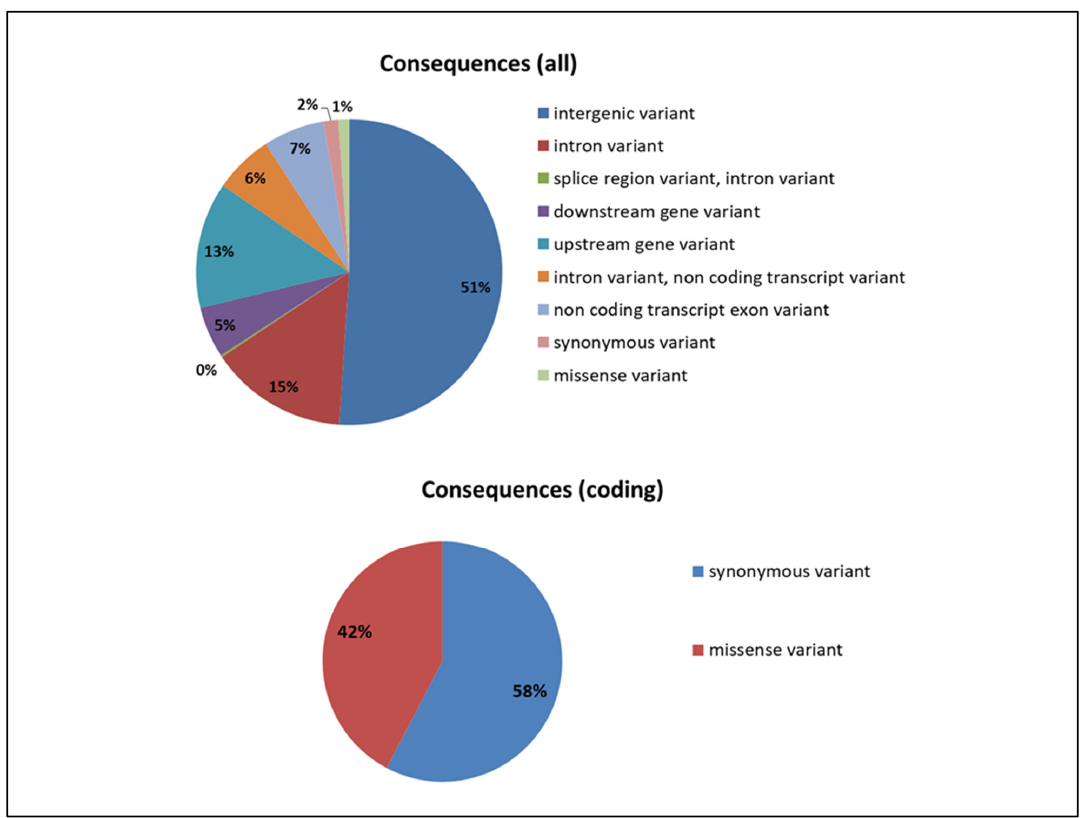
Figure 3. D istribution of SNPs in different functional parts of genes and genome. Figure 3. Distribution of SNPs in different functional parts of genes and genome.